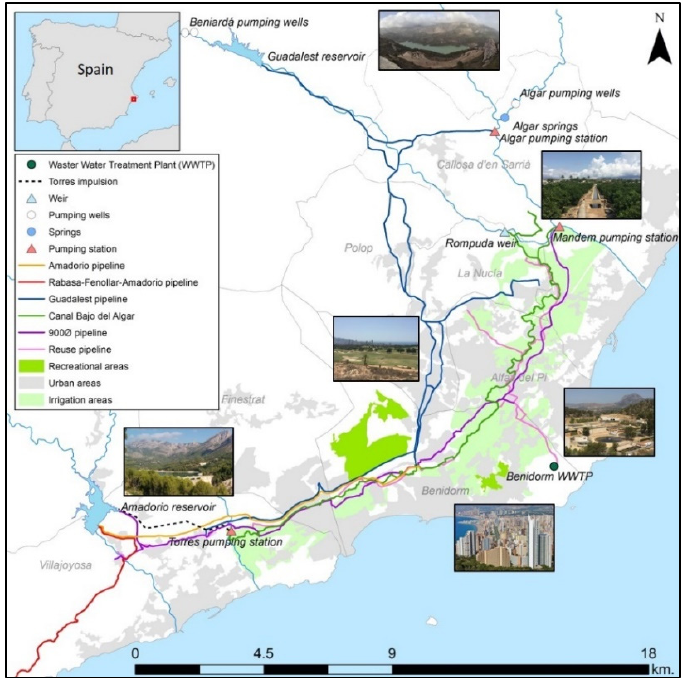
Figure 1. The Marina Baja county water system management. Source: Adapted from [50].